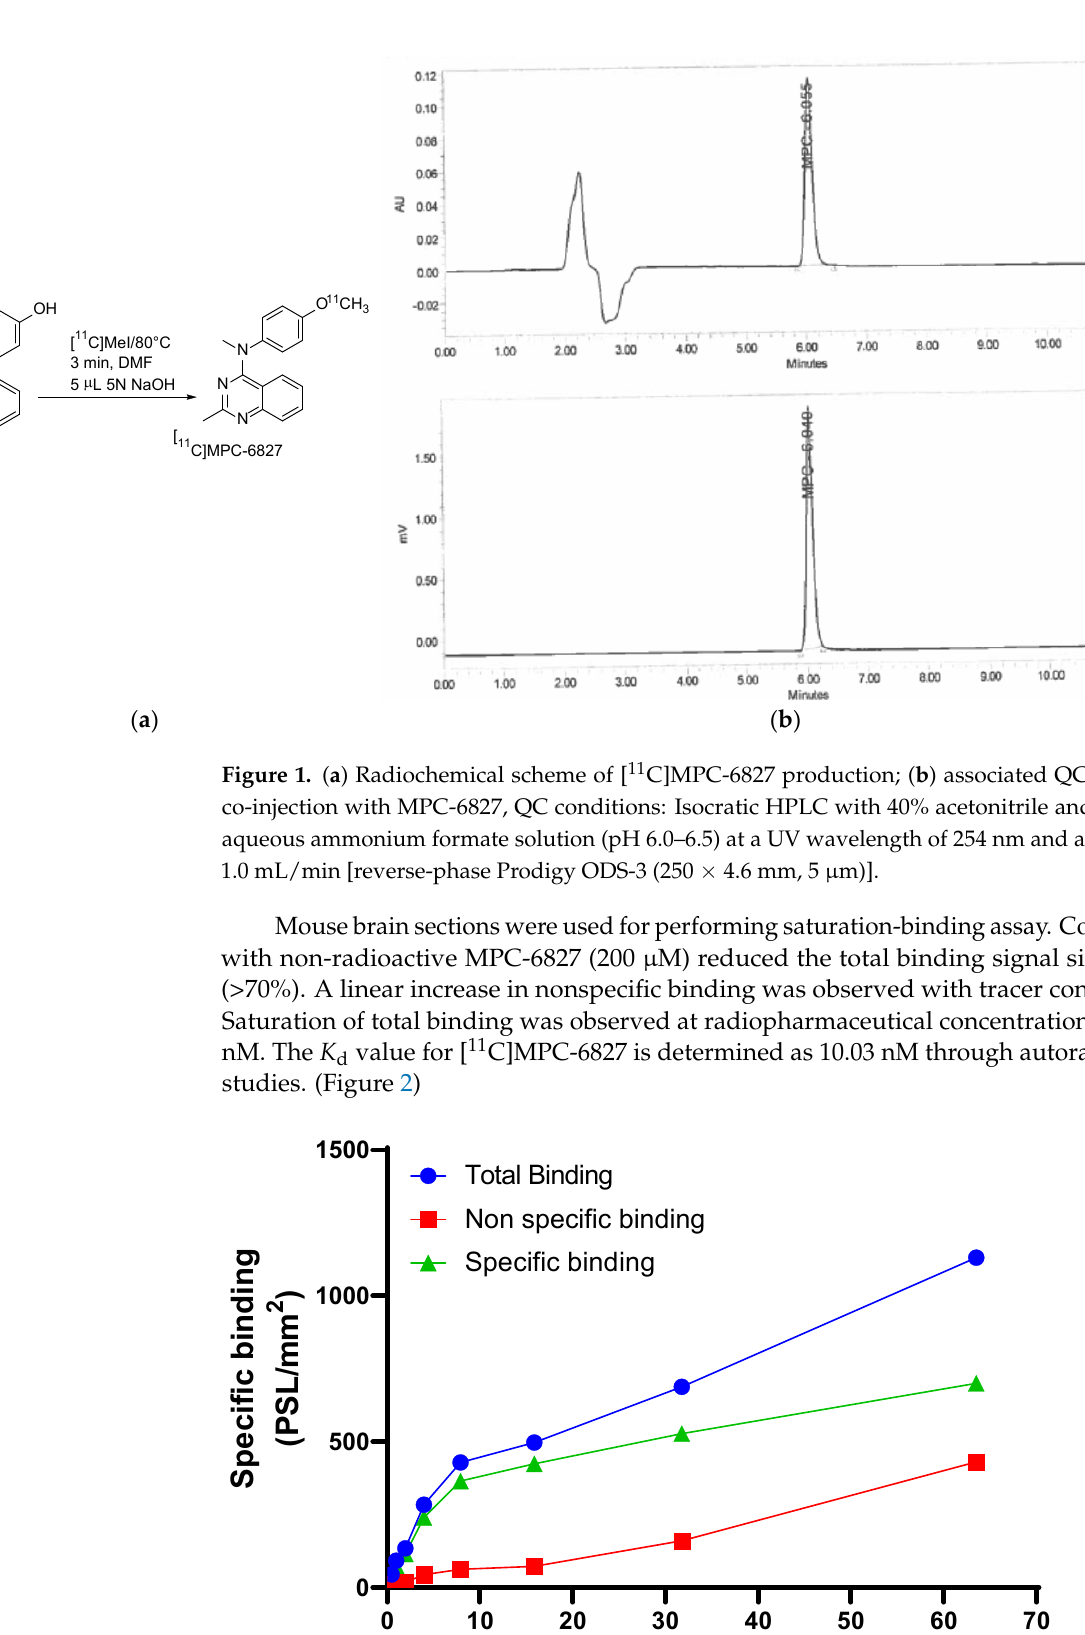
Figure 2. Binding assay of [ 11 C]MPC-6827 using autoradiography studies. T o determine specific [ 11 C]MPC- 6827 binding to mouse brain, a competitive binding assay was performed. The dissociation constant K d was determined as 15.59 nM with B max of 11.86 (fmol/mg), with a statistical significance of * p = 0.04 (Figure 3).